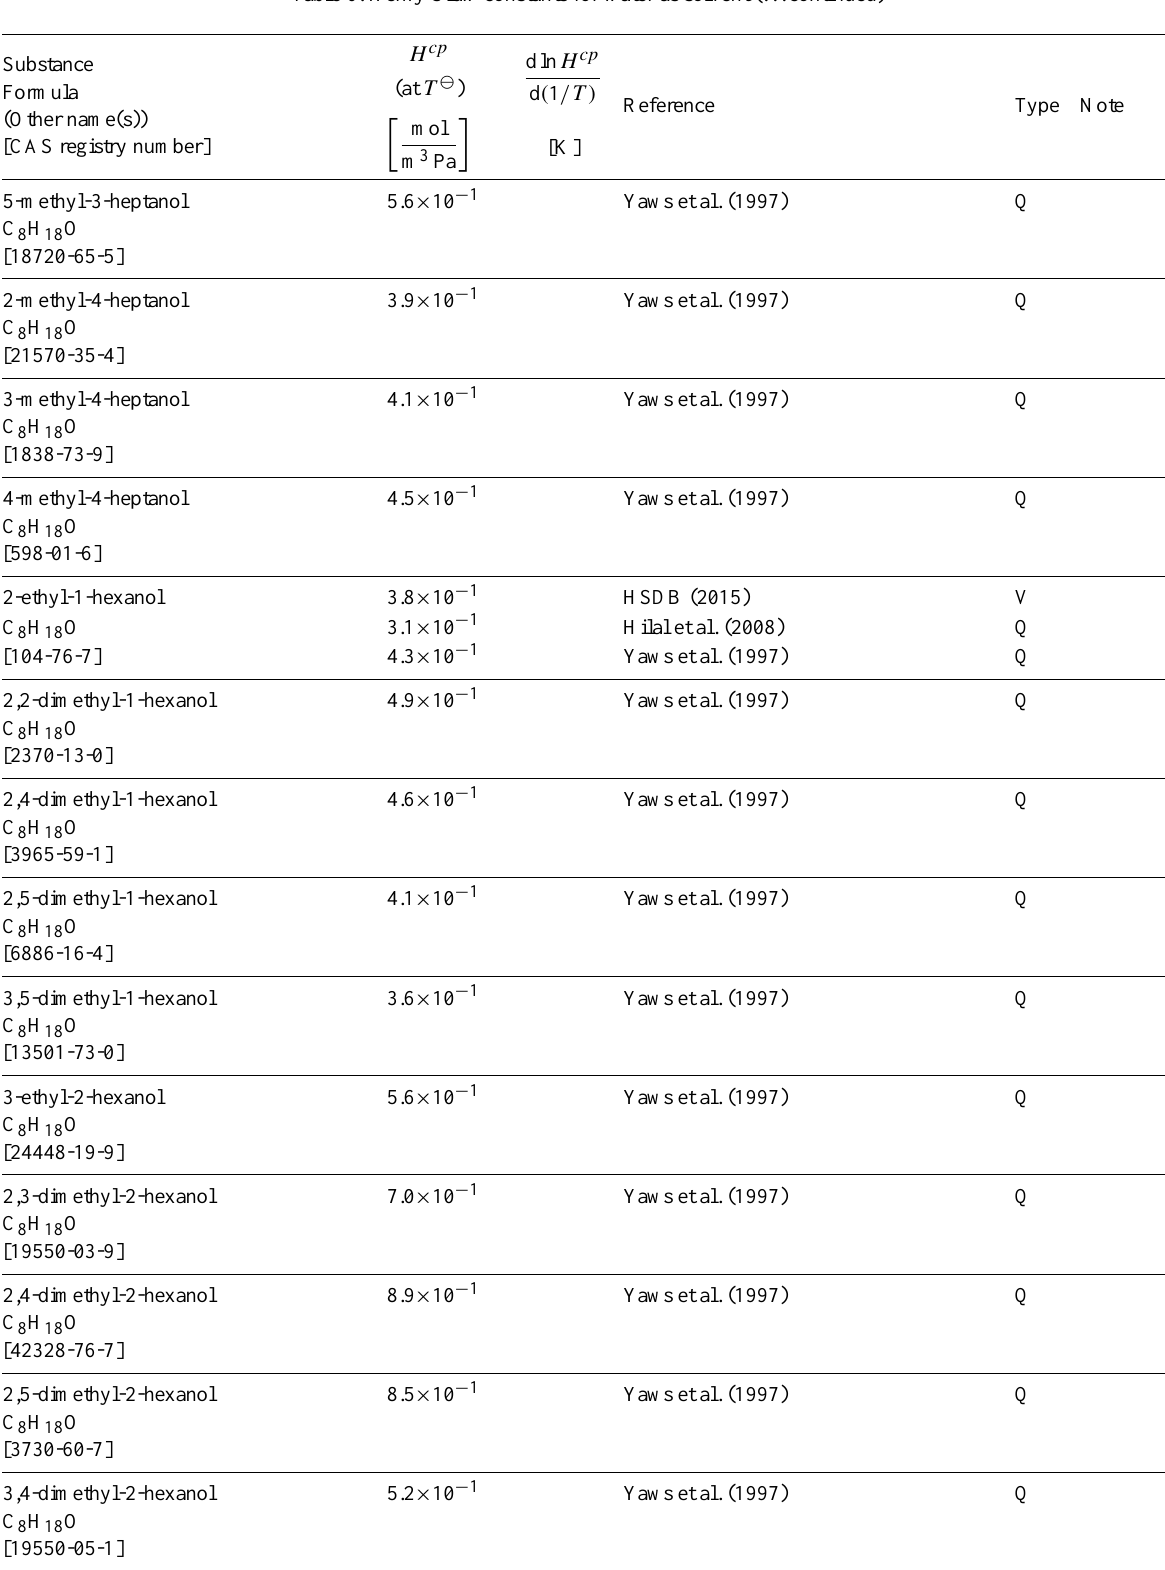
Table 6: Henry’s law constants for water as solvent